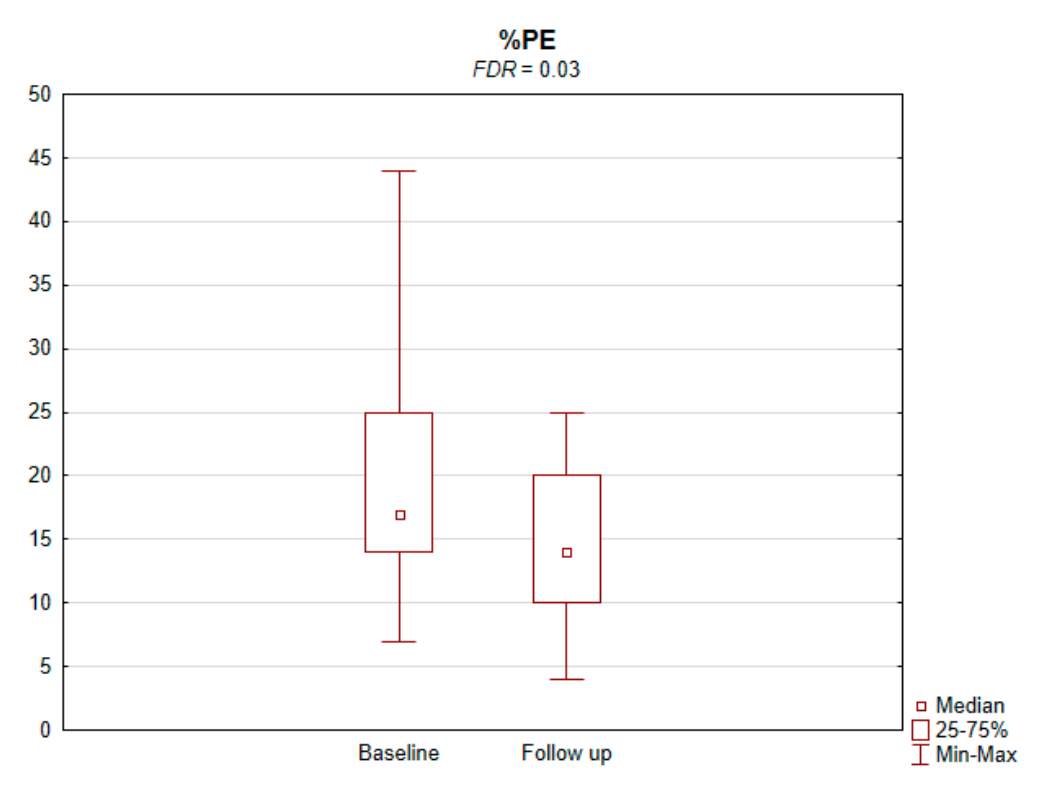
Figure 7. Percentage of perseverative errors (%PE) in Wisconsin Card Sorting Test before and after the intervention. FDR —false discovery rate.